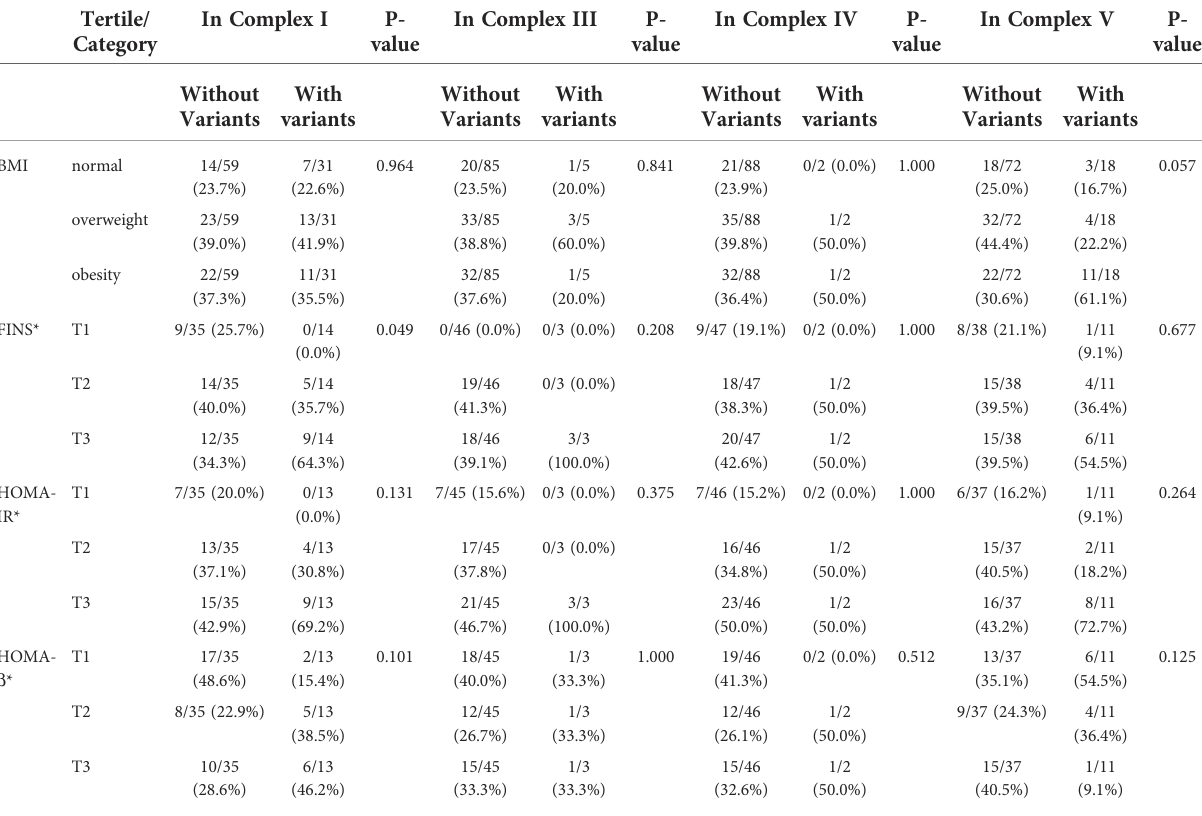
TABLE 5 Comparison of body mass index (BMI) and other traits among the patients with variants and without these variants in the complex I, III, IV, and V domains of